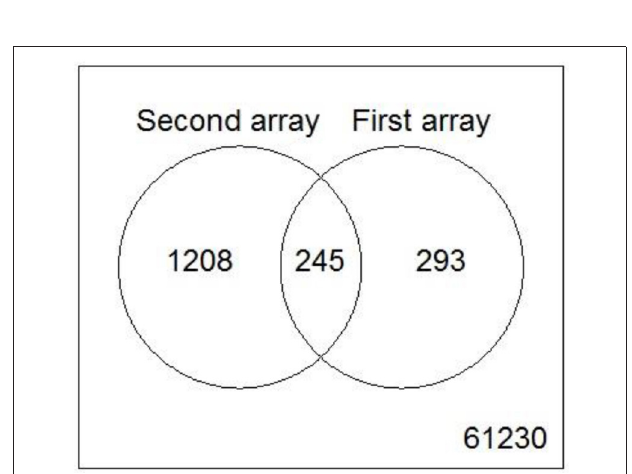
FIGURE 8 | Venn diagram showing the overlap of genes from the core uncoupler set that were regulated in both microarray